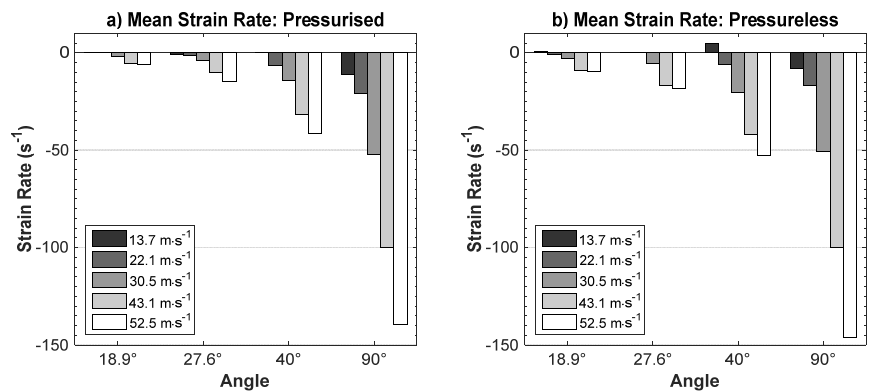
Figure 9. Mean strain rate during impact for pressurised ( a ) and pressureless ( b ) ball cores. Appl. Sci. 2018 , 8 , 371